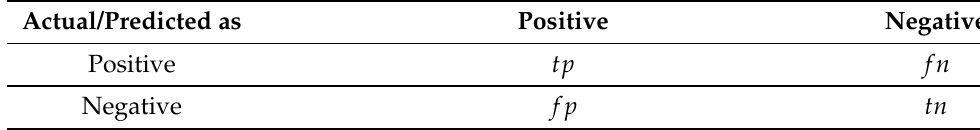
Table 1. Confusion matrix for two-class classification. Actual/Predicted as Positive Negative Positive tp f n Negative f p